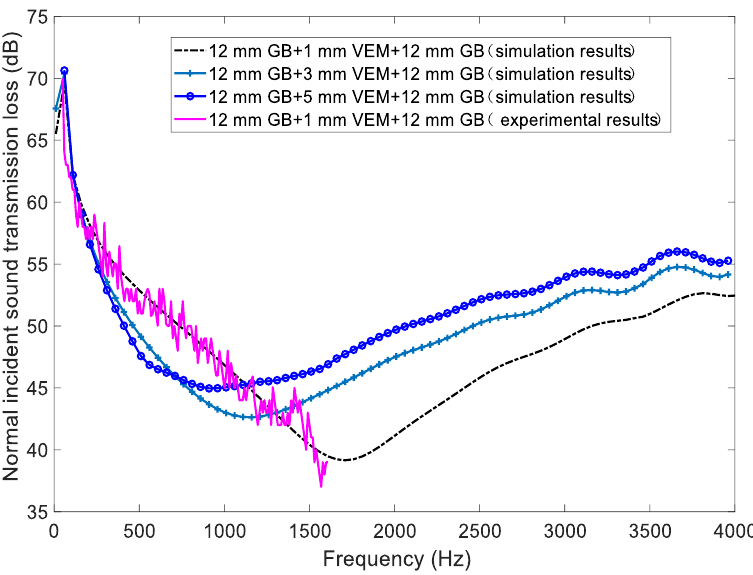
Figure 8. The STL spectrum of the composite partitions with the change of VEM core’s